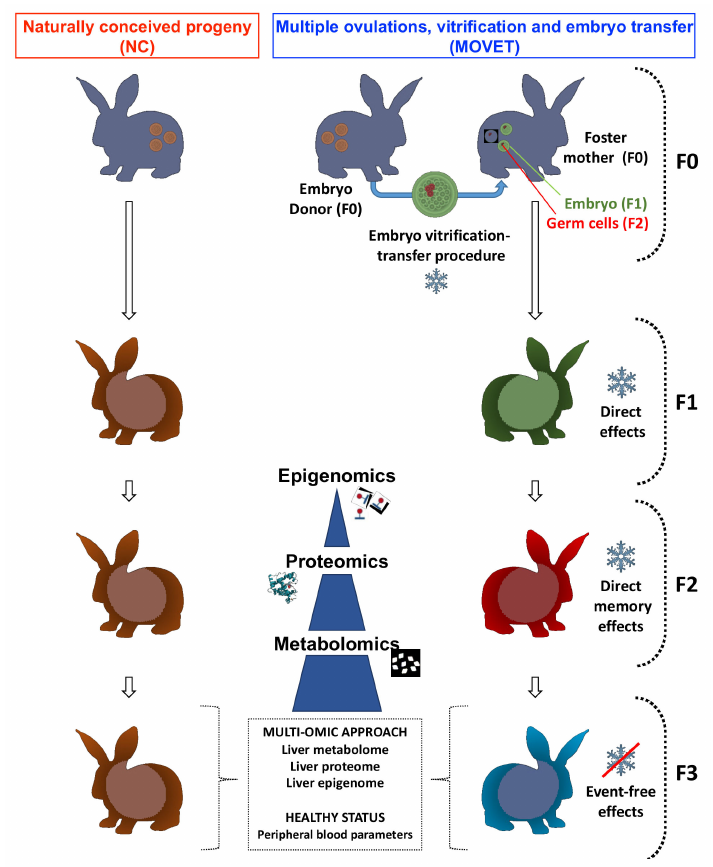
Figure 4. The experimental design used to examine DNA methylation meets proteomics and metabolomics in the liver tissue after embryo manipulation. The experimental progenies were compared in the F3 generation animals to exclude a direct effect of the stimulus on the embryos’ somatic cells and germ